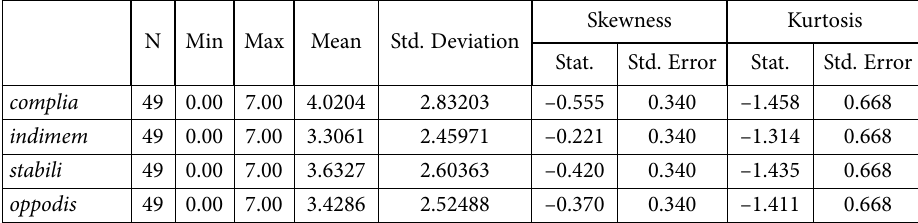
Table 7. Descriptive statistics – H3 (source: authors’ compilation) N Min Max